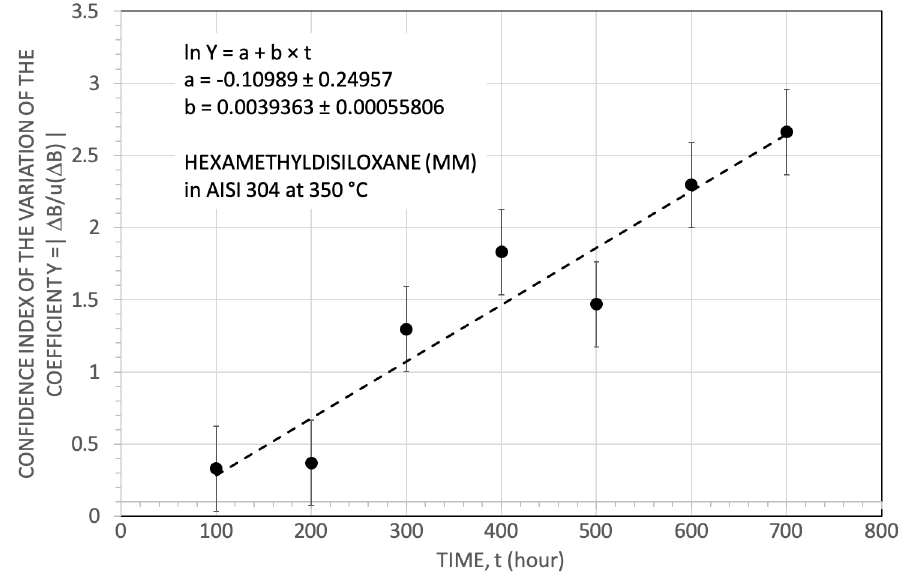
Figure 6. Relative variations (the confidence index) in the B coefficient in Equation (1) for a sample of hexamethyldisiloxane (MM) at 350°C for time intervals of 100h each.